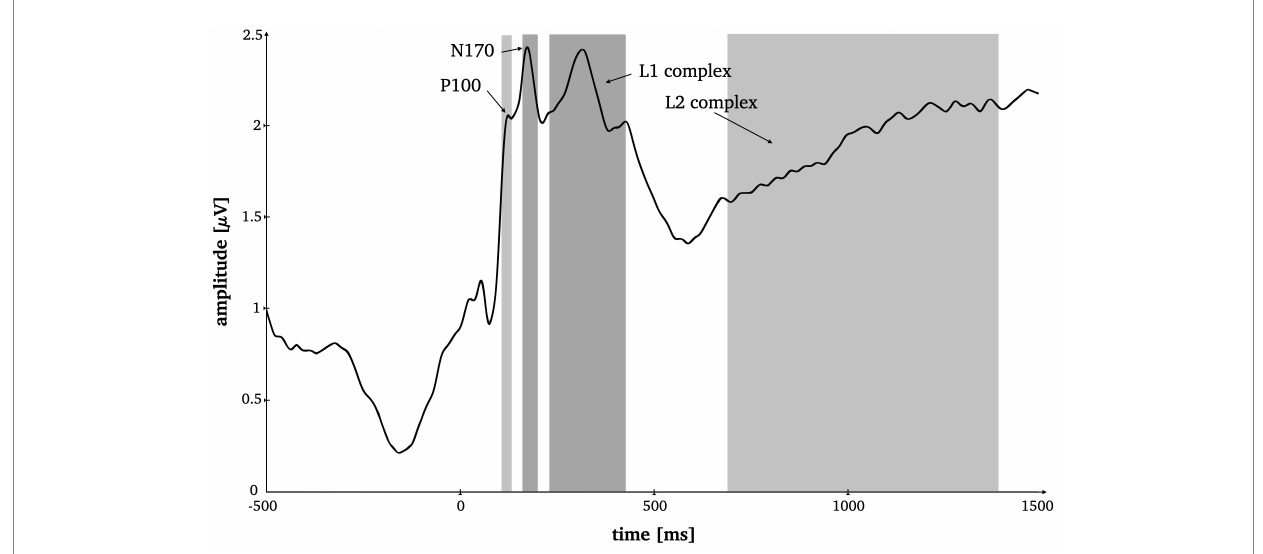
FIGURE 2 Time-by-amplitude plot of the root mean squared ERP averaged over all electrodes for the selection of appropriate time windows for all ERP components. Grey highlighted sections mark the time windows for P1 (95–125 ms), N170 (165–195 ms), L1 (230–420 ms) and L2 (685–1,385